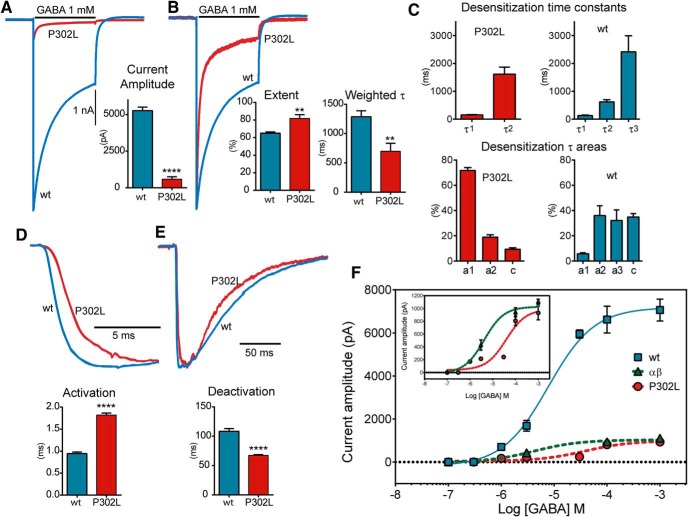
The de novo γ2(P302L) subunit mutation reduces GABA-activated currents and enhances desensitization. A, B, Representative GABA evoked-current traces obtained following rapid application of 1 mM GABA for 4 s to lifted HEK293T cells expressing wt γ2L and mutant γ2L(P302L) subunit-containing α1β3γ2L GABAA receptors. Traces on the right (B) were normalized to illustrate the differences in desensitization between wt and mutant receptor currents. Bar graphs summarized the effects of wt and mutant GABAA receptors on peak current amplitudes and extent and weighted τ of desensitization. C, Bar graphs summarized the effects of wt and mutant GABAA receptors on desensitization time constants (τ1, τ2, and τ3) and relative areas (a1, a2, and a3). D, E, Representative current traces showed activation (D) and deactivation (E) obtained following rapid application of 1 mM GABA for 10 ms to cells coexpressing α1 and β3 subunits with wt γ2L or mutant γ2L(P302L) subunits. The traces were normalized for clarity. Bar plots summarized the differences in activation and deactivation between wt and mutant receptors. F, GABAA receptor concentration-response curves for wt αβγ (solid blue line), αβ (dashed green lines), and mutant γ2L(P302L) subunits (dashed red lines) were obtained. The top left inside panel was a comparison between currents from receptors containing wt αβ and mutant αβγ2L(P302L) subunits. Values were expressed as mean ± SEM (n = 5-6 cells for each experimental condition). The data represented the summary of 17 cells with comparable capacitances (8-12 pF) recorded from three independent transfections. Values were expressed as mean ± SEM. Unpaired two-tailed Student’s t test relative to wt γ2L. ****p < 0.0001, **p < 0.01, respectively. See Table 1 for details.